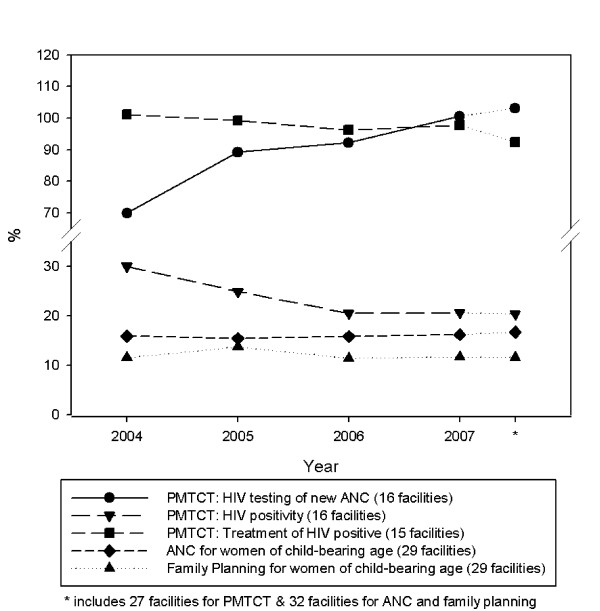
PMTCT and reproductive health coverage, 2004-2007.